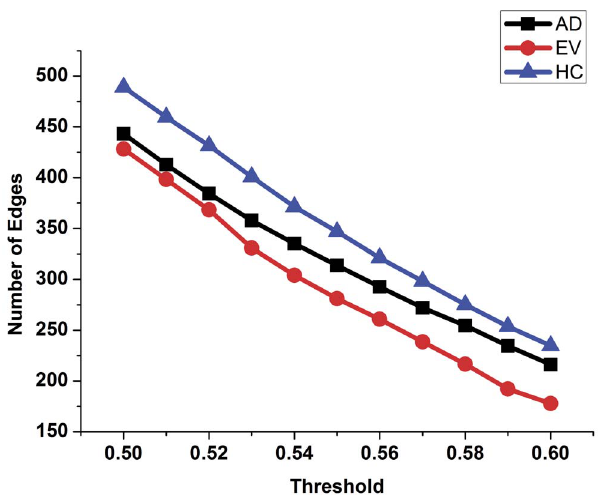
Figure 3. The number of long distance edges ( . 75 mm) of the functional brain network of the healthy controls and the AD patients. Red indicates the healthy control group, black indicates the patients of the AD group.